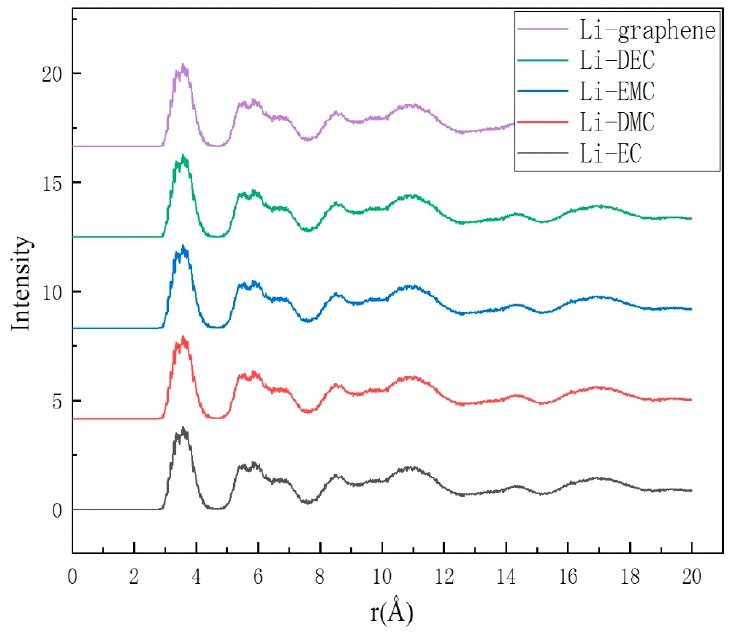
Figure 9. RDFs of Li ions and carbonate electrolytes in the HGNS system.